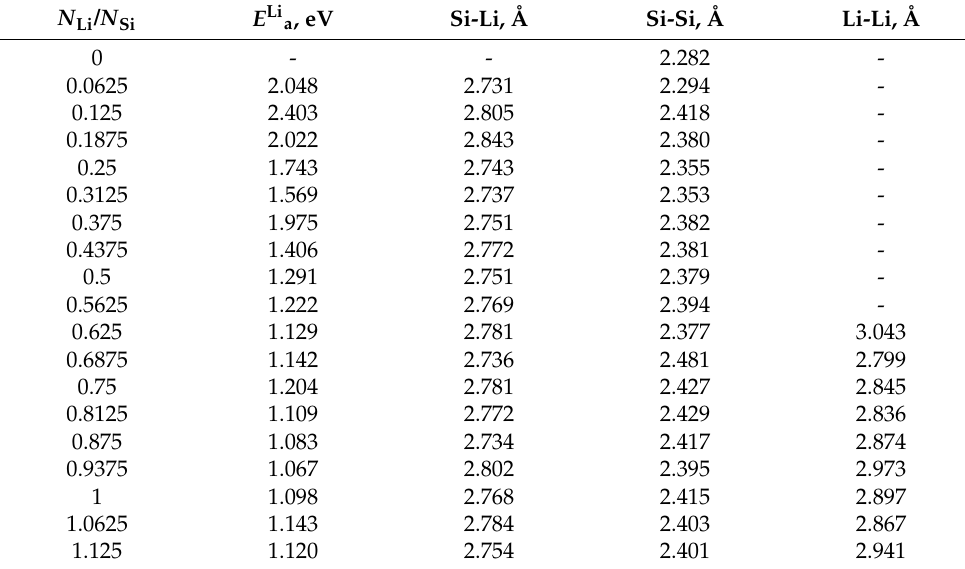
Table 1. Dependence of properties * of the “silicene on bilayer graphene” system on the number of adsorbed lithium